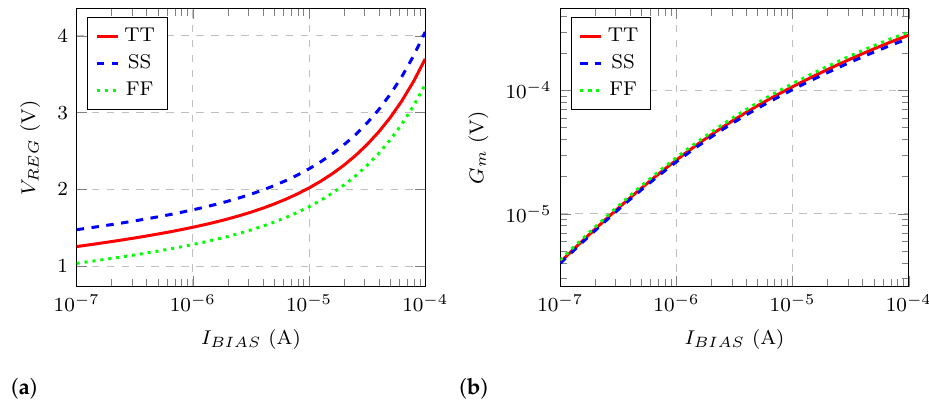
Figure 4. ( a ) V REG × I BIAS , and ( b ) G m × I BIAS